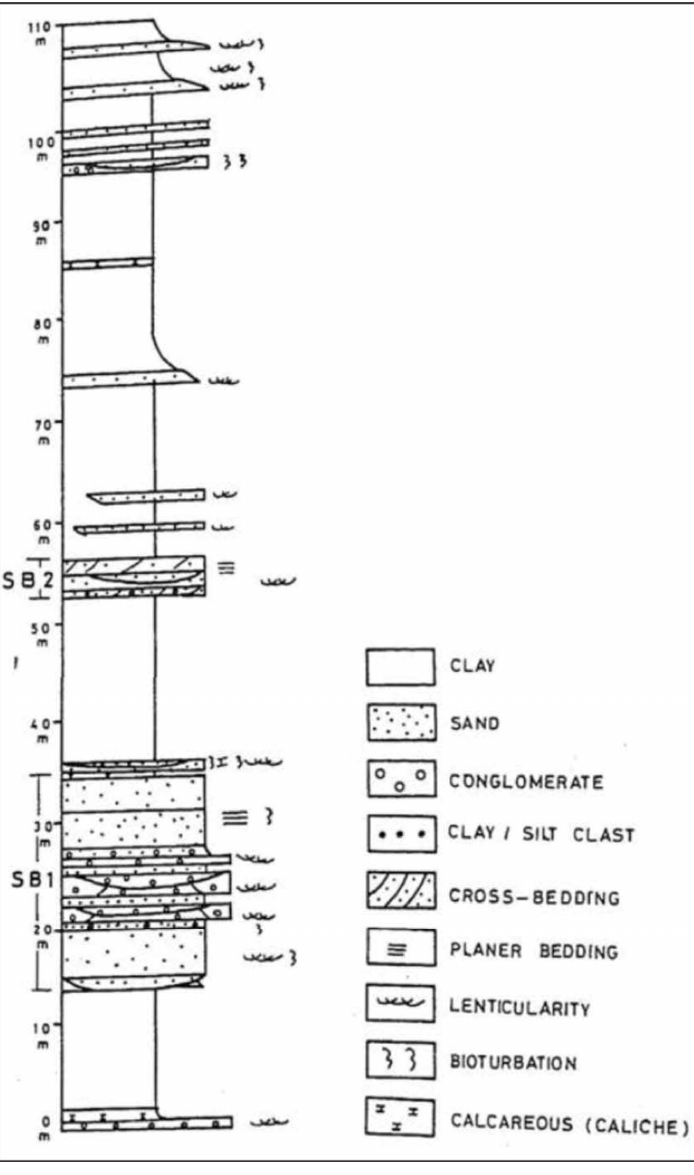
size [16,17]. The outer wall layer of the pollen grain is called the exine, while the inner